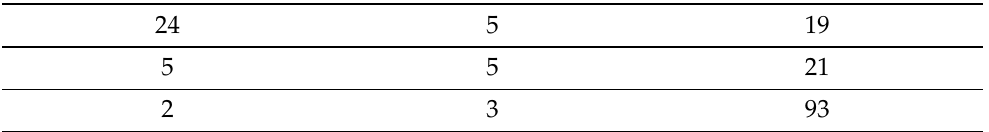
Table 14. Confusion matrix for Glove embedding with the RFE (RF) feature selection method; 150 features.